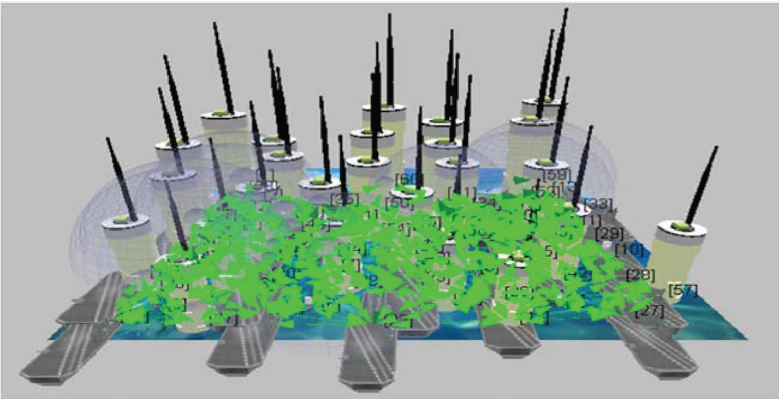
Figure 5: Proposed scenario of underwater wireless communication in 3D visualization.